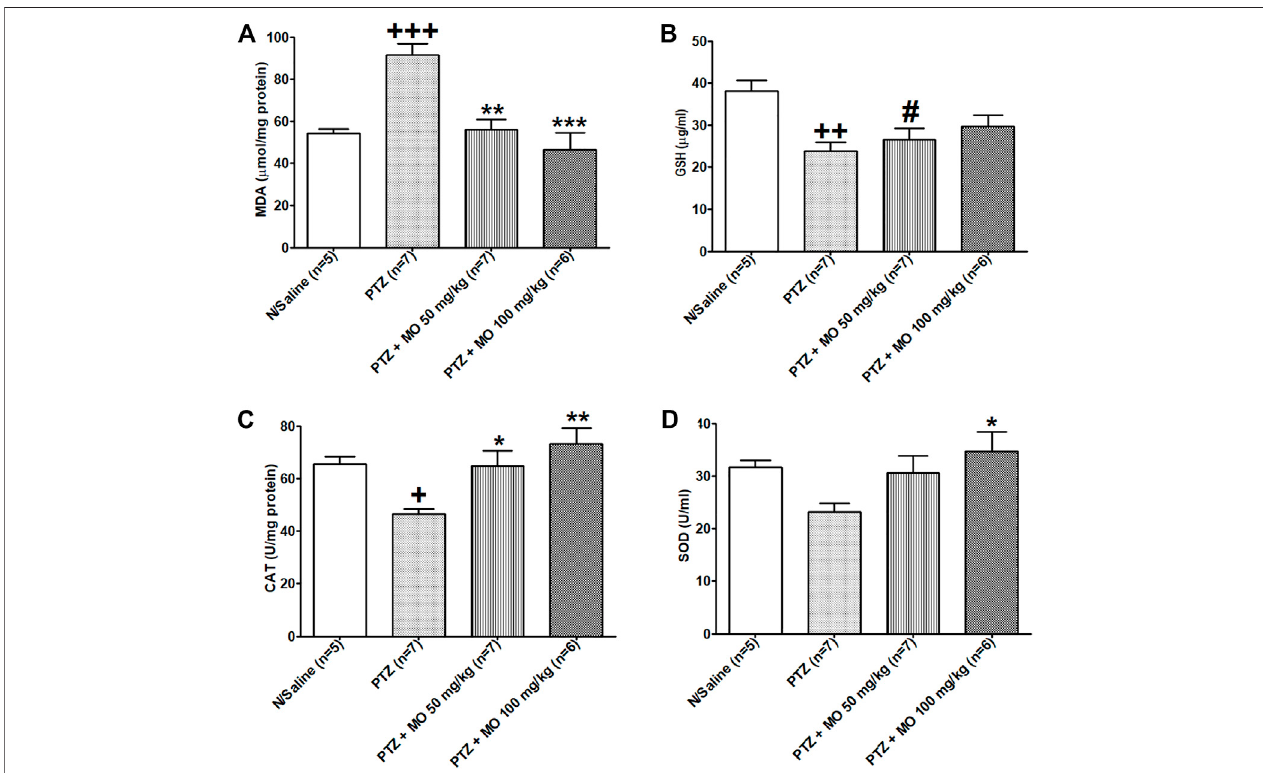
FIGURE 9 | Effects of Melissa of fi cinalis L. essential oil (MO) on oxidative stress markers in brains of PTZ-kindled rats. (A) Malondiadéhyde (MDA) level, +++ p < 0.001(N/SalinevsPTZ),** p < 0.01(PTZvsPTZ+MO50 mg/kg),*** p < 0.001(PTZvsPTZ+MO100 mg/kg); (B) Glutathione(GSH)level,++ p < 0.01(N/SalinevsPTZ), # p < 0.05 (PTZ + MO 50 mg/kg vs N/Saline); (C) Catalase activity, + p < 0.05 (N/Saline vs PTZ), * p < 0.05 (PTZ vs PTZ + MO 50 mg/kg), ** p < 0.01 (PTZ vs PTZ + MO 100 mg/kg); (D) Superoxide dismutase (SOD) activity, * p < 0.05 (PTZ vs PTZ + MO 100 mg/kg). n (cid:2) number of animals tested. Mean ±